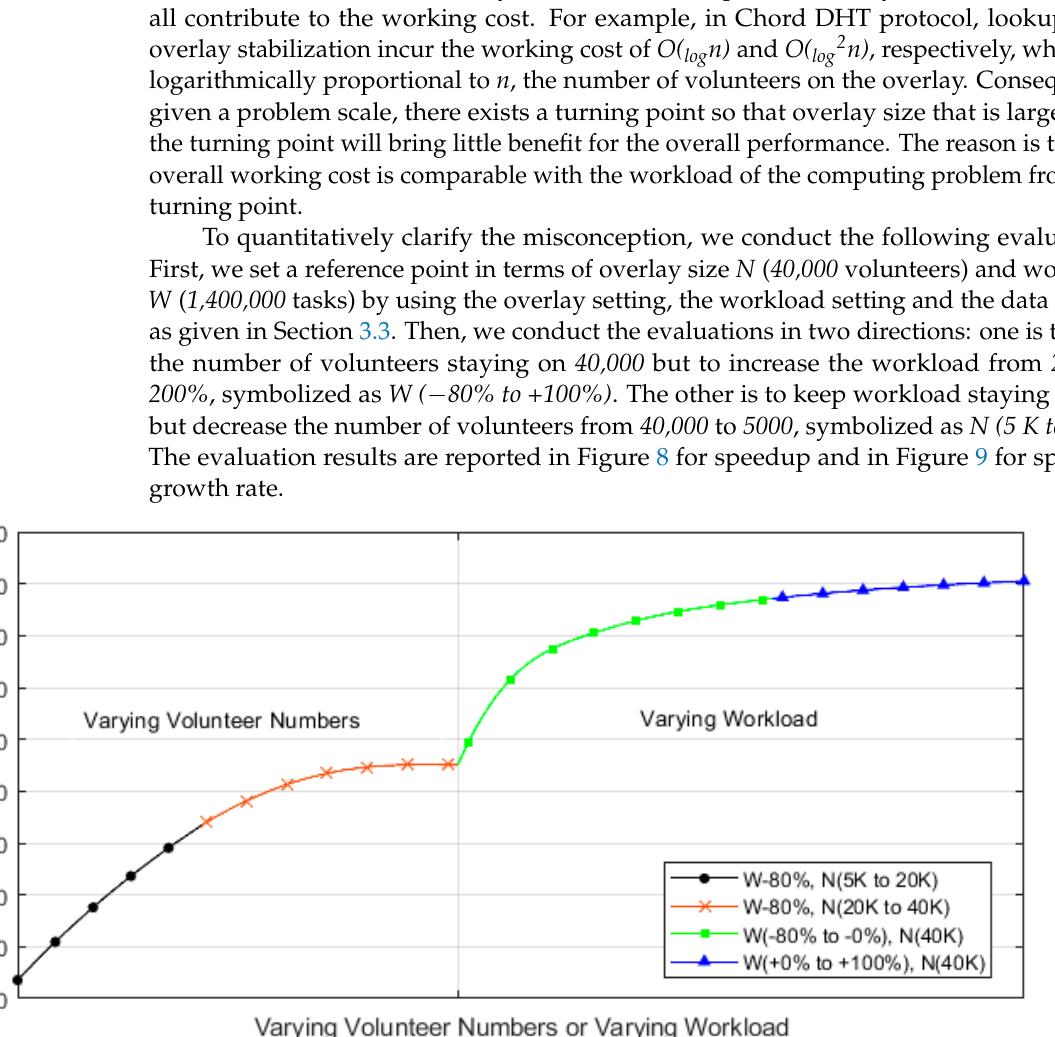
Figure 8. The speedup vs. varying volunteer numbers or varying workload.